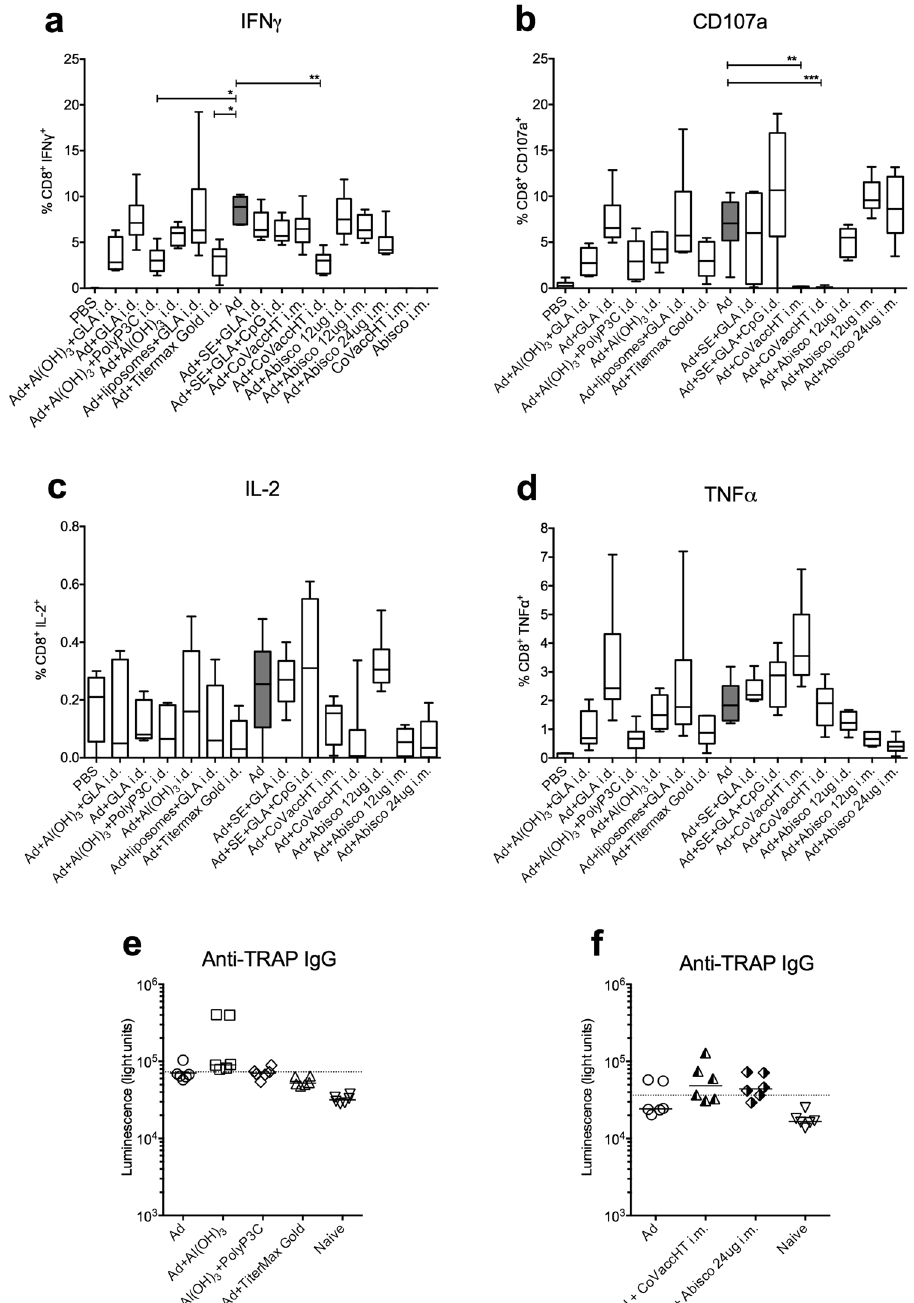
Figure 2. Antigen-specific cytokine producing CD8 + T cells and antibody titres in the peripheral blood of the immunised animals one day prior to malaria challenge. Two weeks after a single vaccination with different Ad-ME.TRAP/adjuvant combinations (Ad vector was given at 5 × 10 9 v.p./dose), we assessed Pb9-specific intracellular cytokine levels in the peripheral blood of vaccinated Balb/c mice (n = 6 per group) (panels a–d). Isolated PBMCs were stimulated with Pb9 for 5 h and production of IFN γ , TNF α and IL2 and degranulation (CD107a expression) by CD8 + T cells assessed by ICS and flow cytometry. Ranked one-way ANOVA analysis (Kruskal-Wallis) with Dunn’s test for multiple comparisons was used to assess statistical significance of the differences between groups ( * p < 0.05, ** p < 0.01). Representative FACS dot plot data are shown in Supplementary Figure 2a. Panels e and f show total IgG antibody titres against the TRAP antigen in the serum of some of the vaccinated groups, measured two weeks post immunisation using the LIPS assay. The dashed line indicates the cut-off level of detection (average of 6 naïve samples plus 2 standard